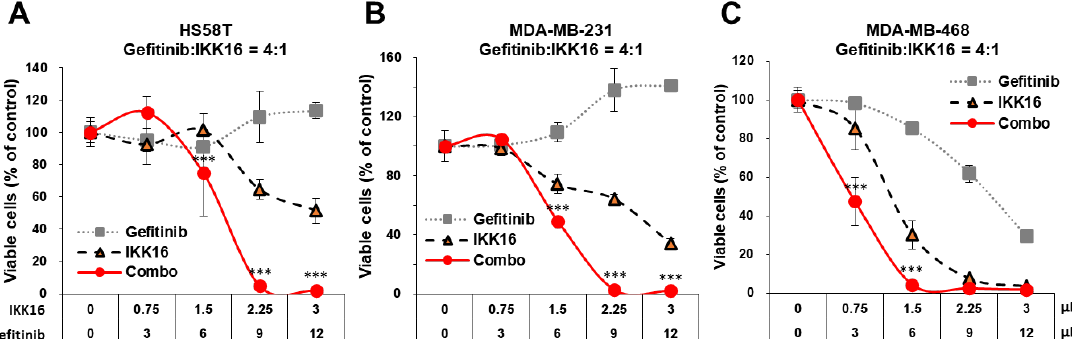
Figure 2. Treatment with IKK16 increased the sensitivity of TNBC cells to gefitinib. TNBC cells were treated with serially diluted concentrations of IKK16 in combination with gefitinib for 72 h. Cell viability was determined by MTT assay. ( A – C ) The combination effects of gefitinib with IKK16 in two MSL (HS578T and MDA-MB-231) and one BL1 (MDA-MB-468) type TNBC cells. Data are represented as the mean ± SD of results from at least three independent experiments performed in triplicates. ***, p < 0.001.